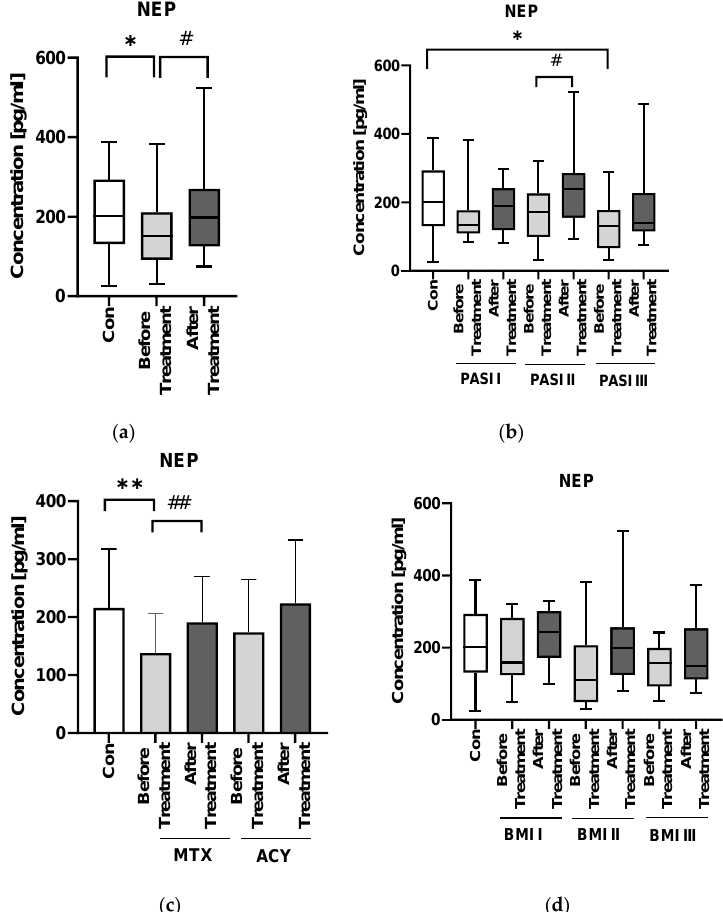
Figure 6. Serum NEP in psoriasis patients before and after total therapy ( a ), both drugs separately ( b ) and with regard to PASI subdivision ( c ) and BMI ( d ). */** means the existence of statistically significant difference between patients single group compared to controls with p < 0.05/ p < 0.01; #/## means the existence of statistically significant difference between patients before and after the treat- ment with p < 0.05/ p < 0.01.